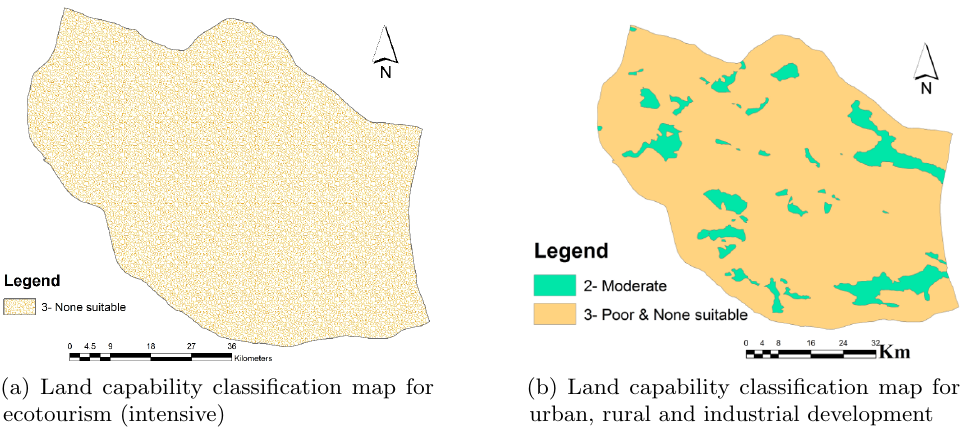
Figure 5: Land capability classification maps